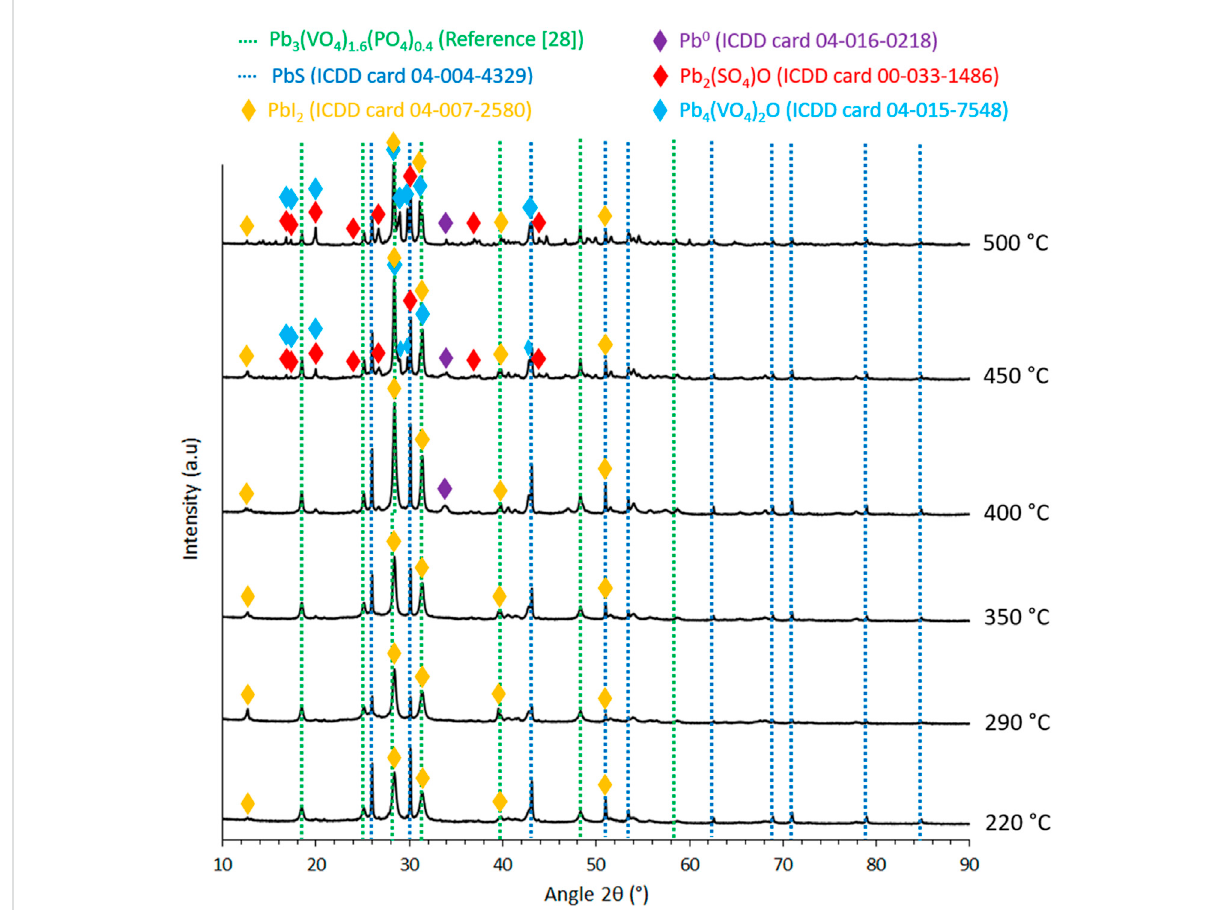
FIGURE 5 X-Ray diffractograms of lead-vanadate sorbents calcined at different temperatures after iodine capture.